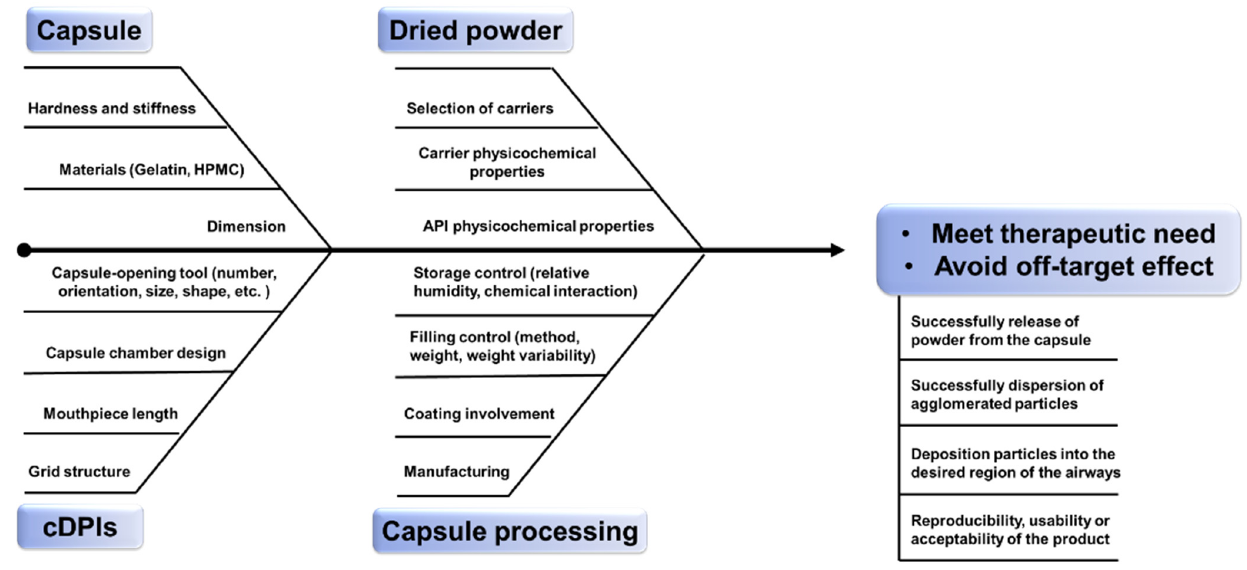
Figure 1. Quality by Design (QbD) framework of cDPIs.